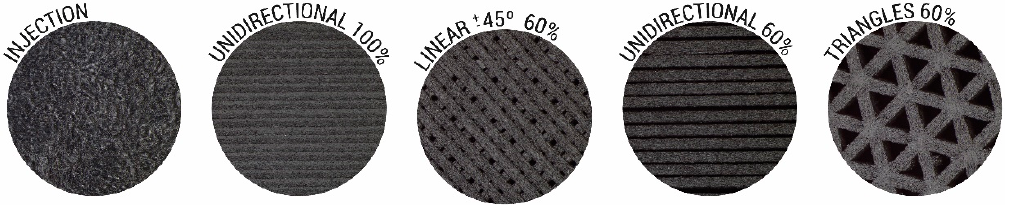
printed Figure 1. Stereomicroscope images (×1.25) of the appearance of the injected and different patterned printed samples.